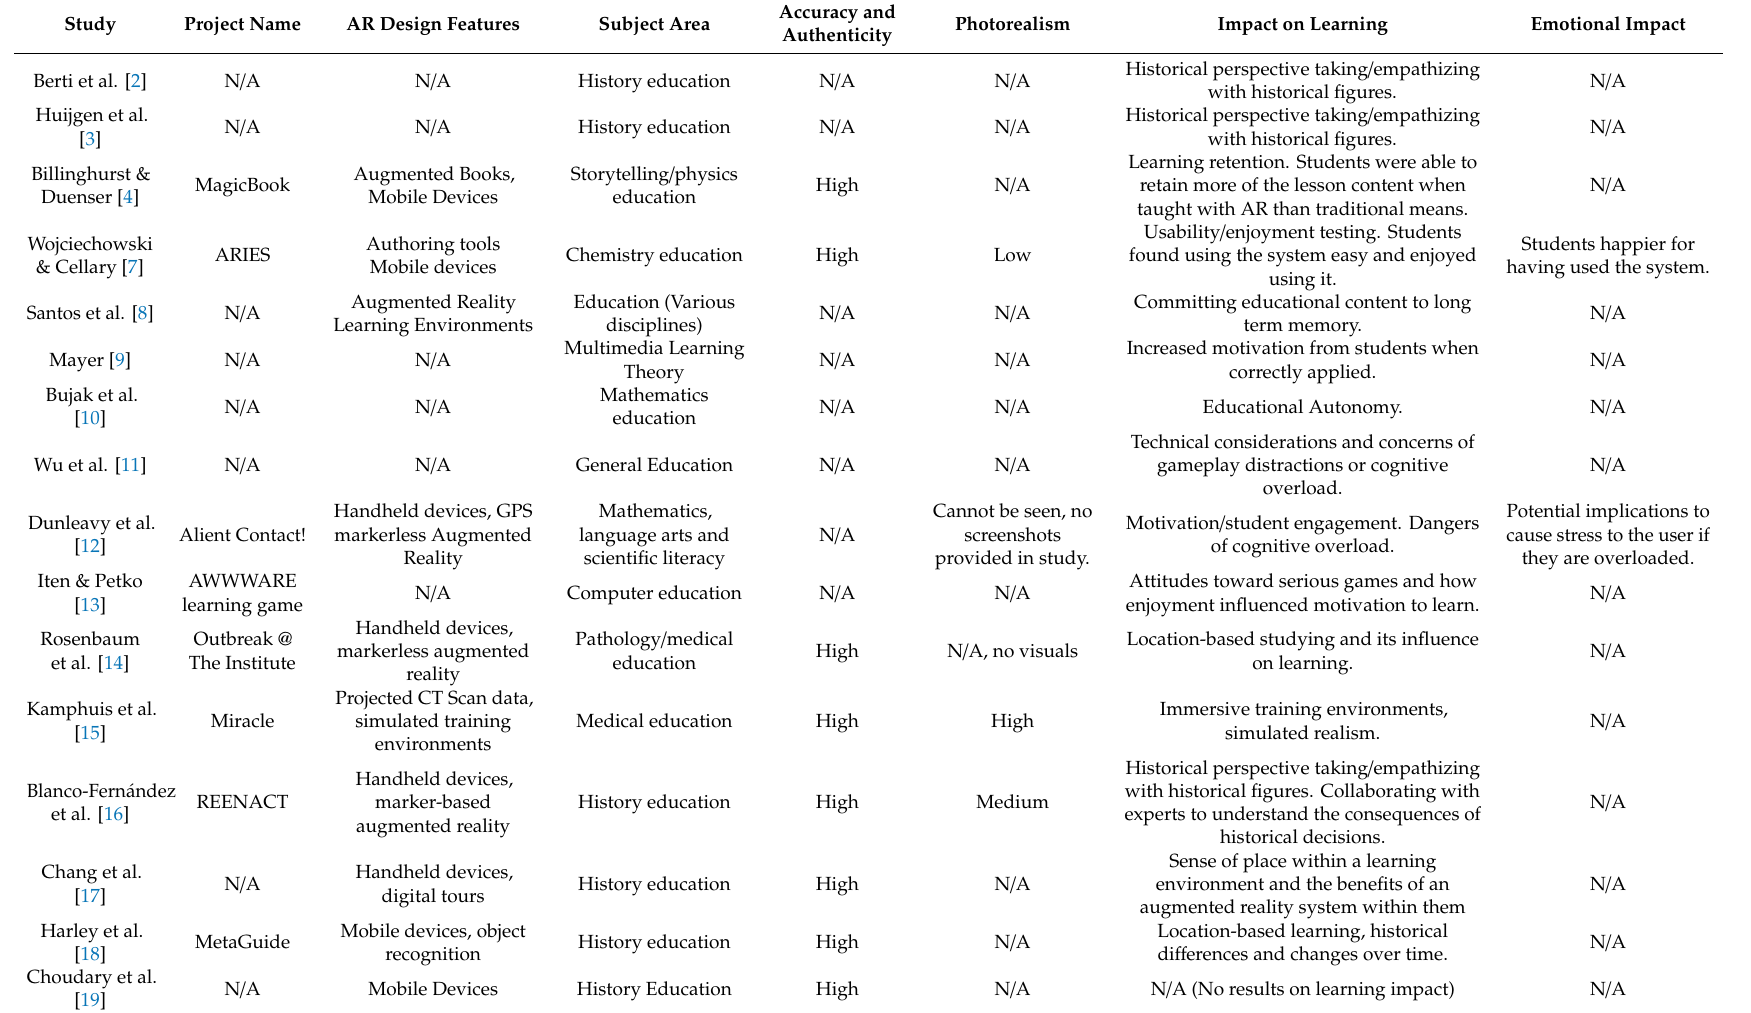
Table 1. List of augmented reality systems for